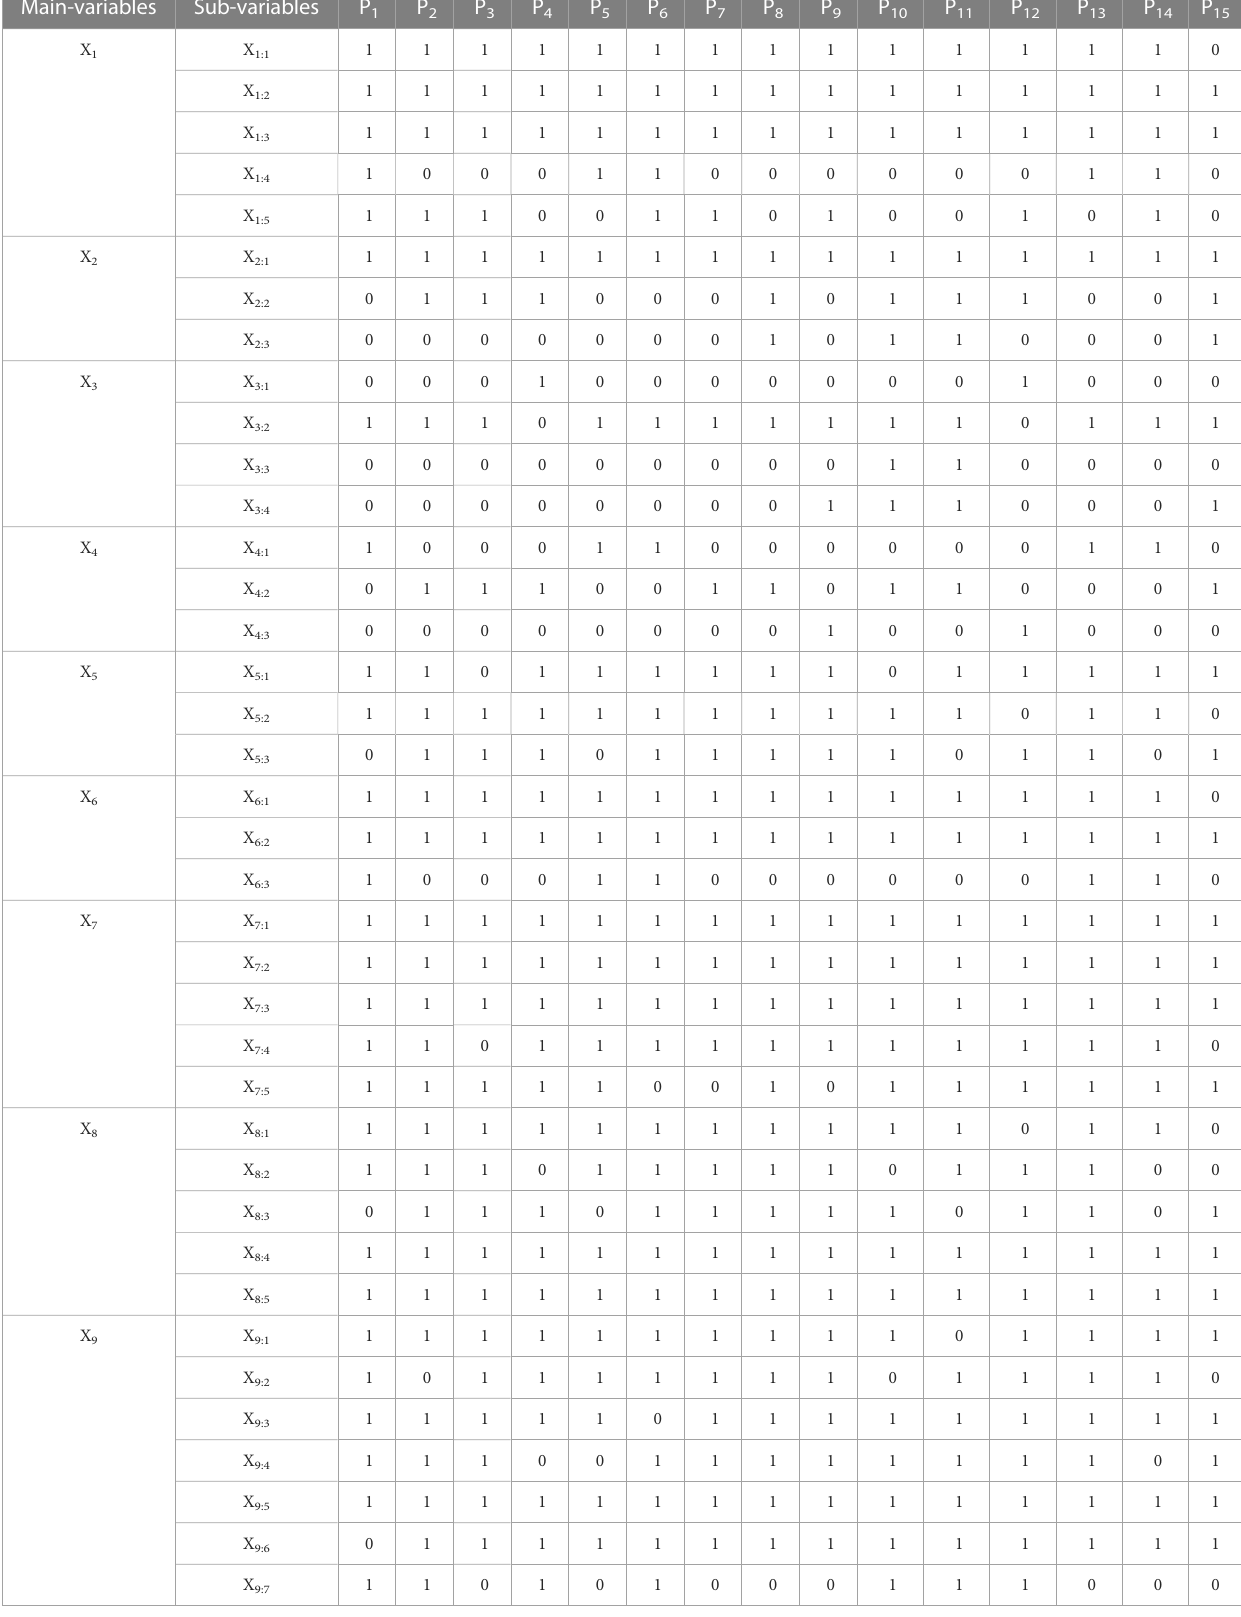
TABLE 3 The multi-input-output table for studied China ’ s shipping decarbonization policies.